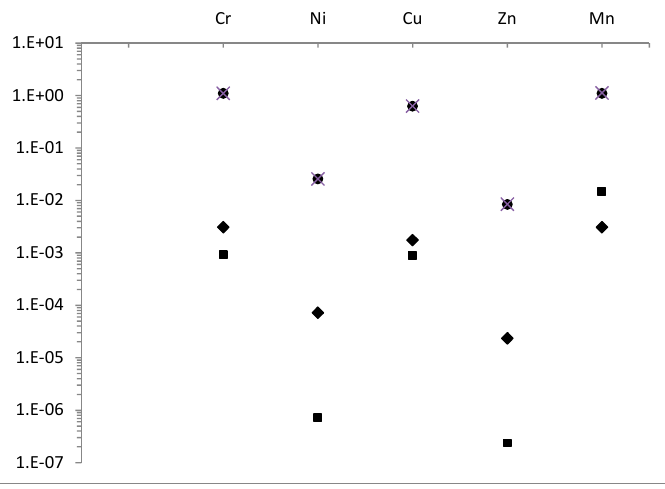
Figure 3. HQs for potentially toxic elements from Uttarakhand, India. Symbols: HQs for ingestion: Crosses; HQs for dermal contact: Diamonds; HQs for inhalation: Squares.